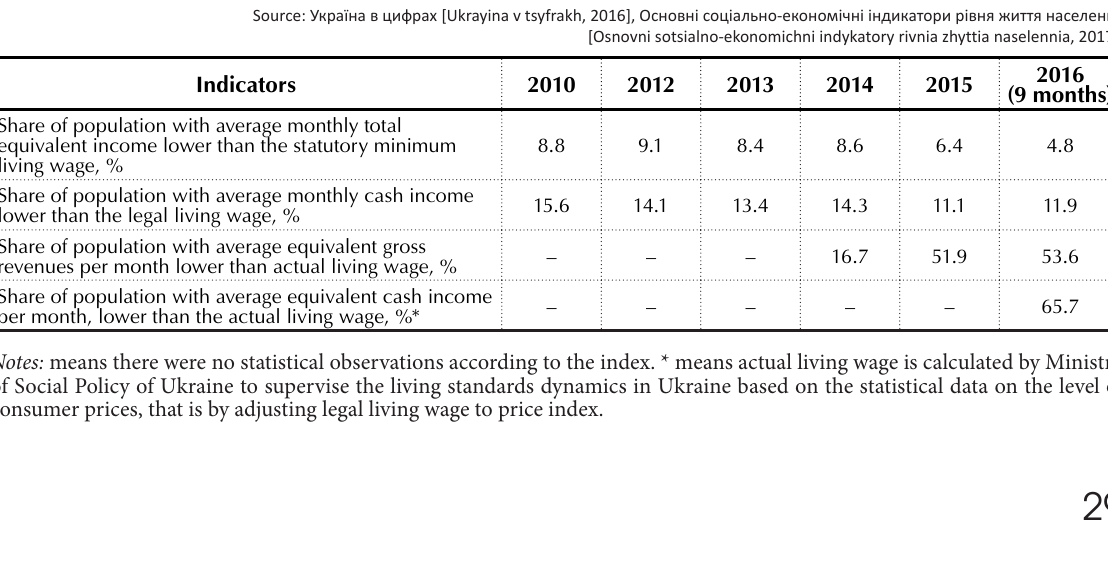
Table 4. Main social and economic indicators of population’s